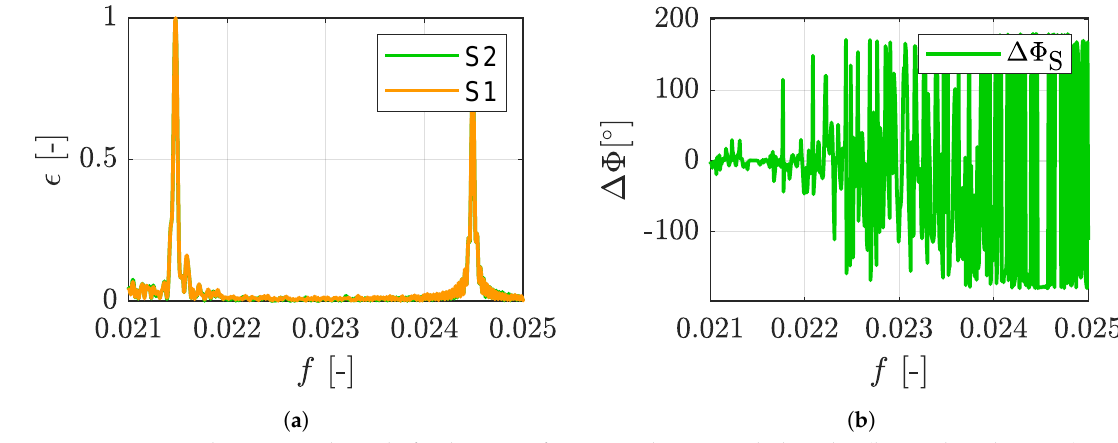
Figure 11. Vibratory Mode 6: Shaft vibrations, frequency domain and phase lag (low order vibrations). ( a ) Normalized amplitude of both shaft SGs during resonance M6 (low order vibrations); ( b ) Phase lag ∆ Φ S of shaft SGs during resonance M6 (low order vibrations).